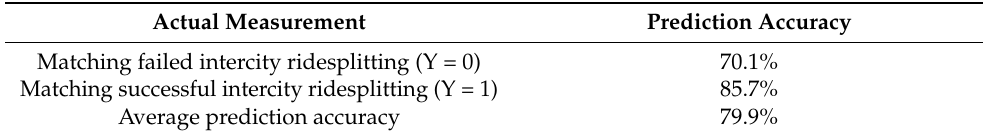
Table 5. Prediction results of the Shizuishan model.